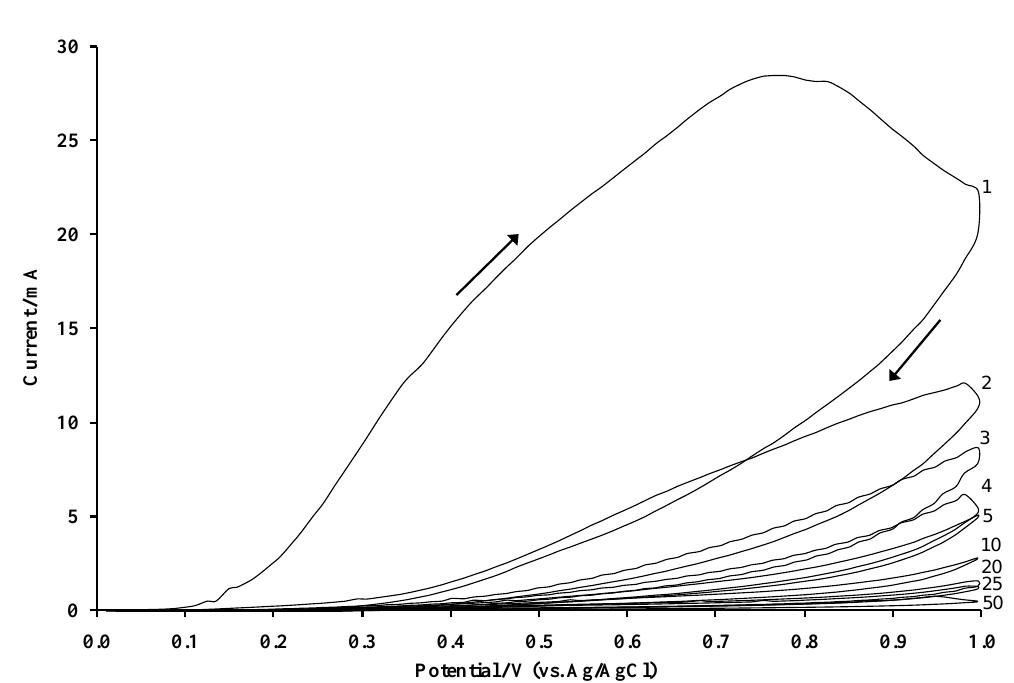
o-phenylenediamine dihydrochloride on a sheet of 100 screen printed carbon electrodes (50 Sweeps). [ Supporting electrolyte: phosphate buffer (pH 7.4, 5.1  10 –3 M). Scan rate: 50 mVs –1 ].